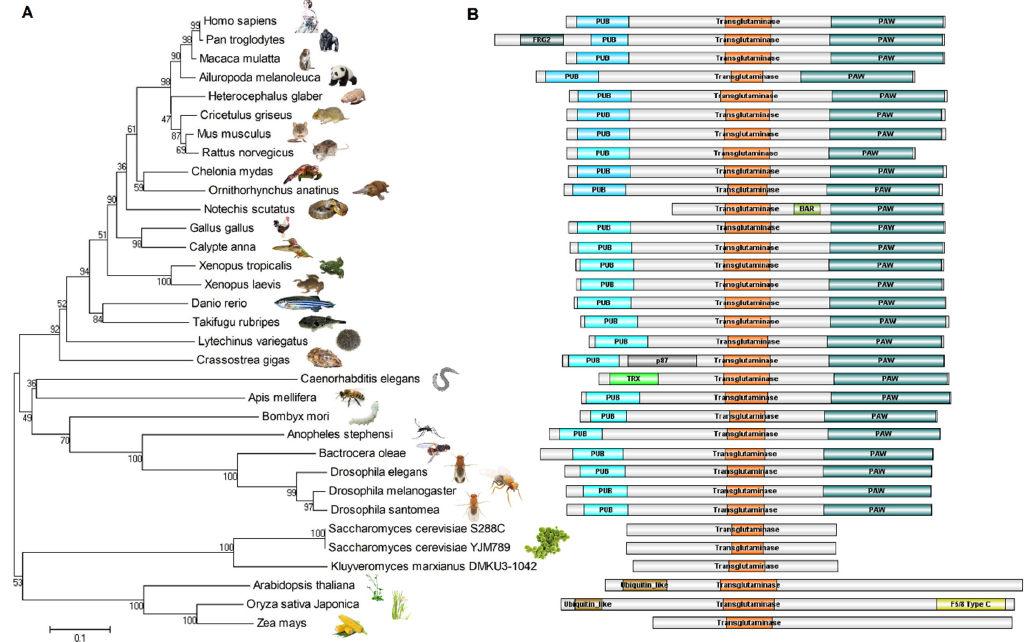
Figure 4. Evolutionary relationships of NGLY1 in 33 taxa. ( A ) Evolutionary phylogeny; ( B ) Protein structures of Ngly1.